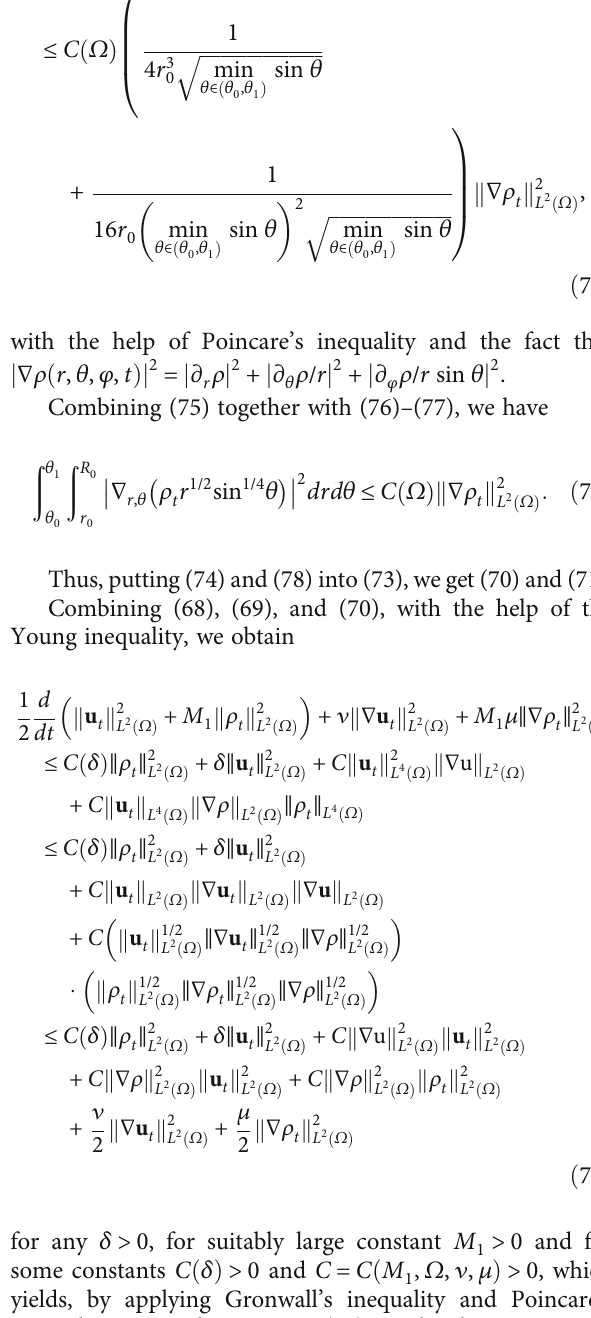
ffiffiffiffiffiffiffiffiffiffiffiffiffiffiffiffiffiffiffiffiffiffiffiffi min